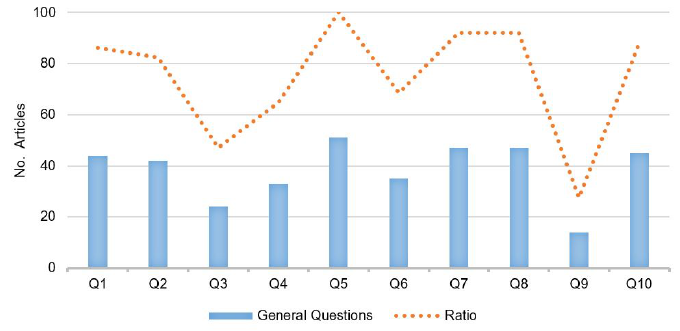
Figure 3. Study quality